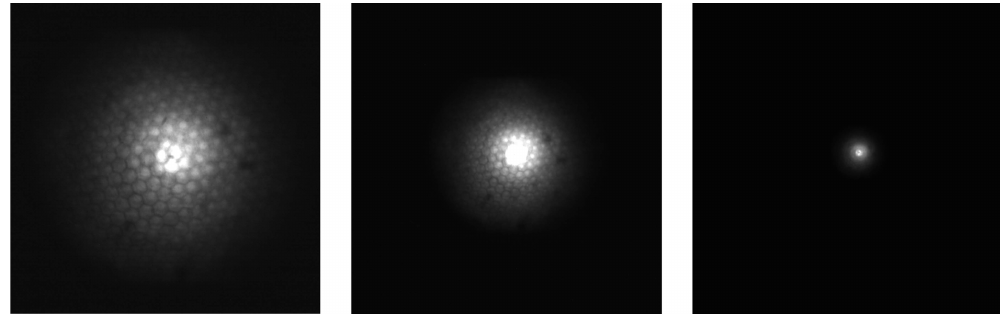
Figure 10 Beam intensity distribution for PC-246 for the primary beam energy 10 keV for different distances (see z in Fig. 2). With 6 mm distance between the left and middle images and 6 mm distance between the middle and right images.